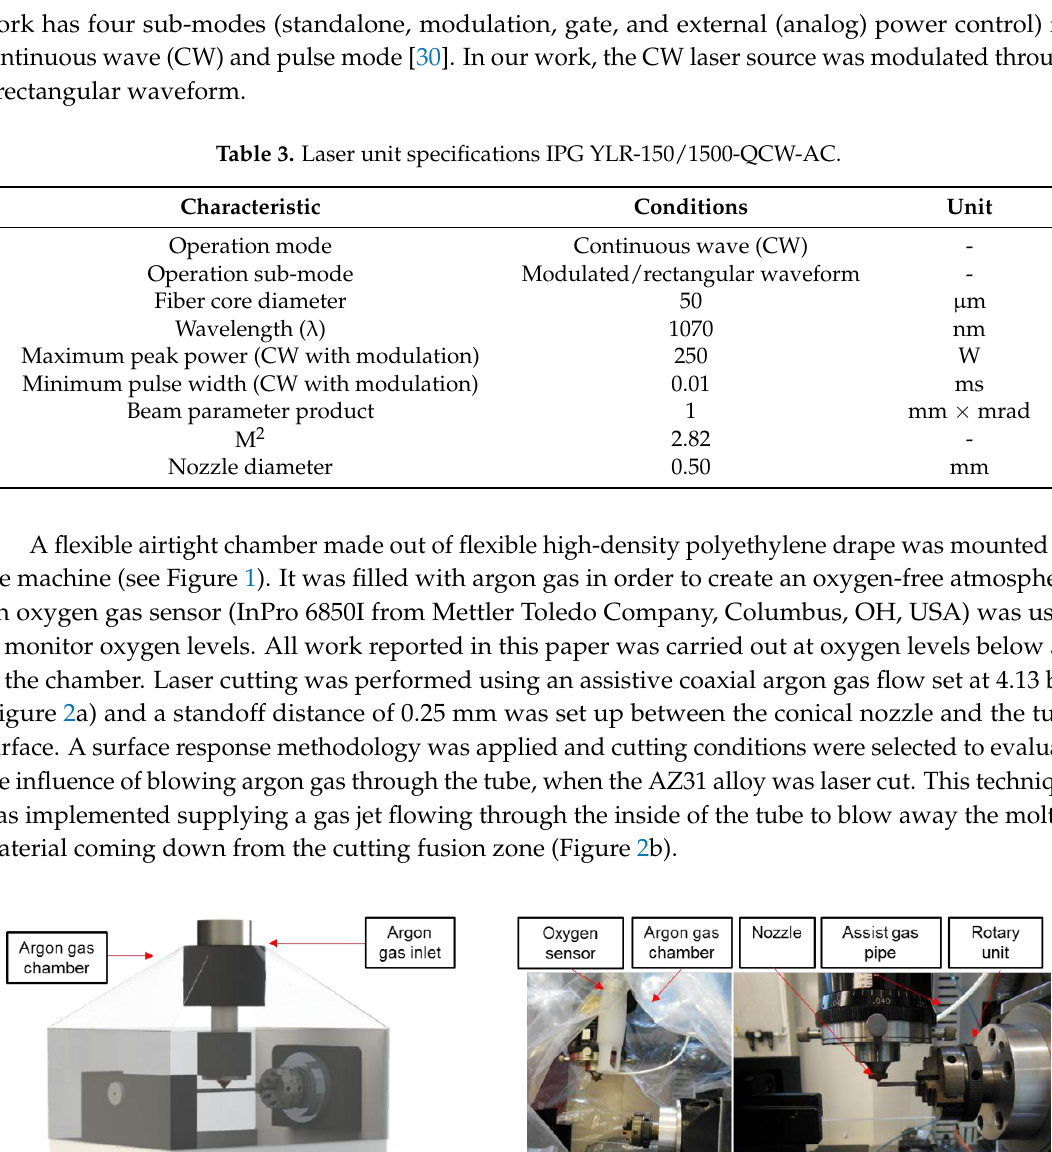
( b ) Figure 2 . Experimental conditions under study: ( a ) Ar assistive atmosphere; ( b ) Ar assistive atmosphere and blowing through the tube. 2.3. Experimental Factors A pulse overlapping factor O f was used to relate periodic striations on the cut edge produced by the laser beam. This term is associated with cutting speed v f , pulse frequency f , and spot diameter of laser beam d by the equation [31,32]: